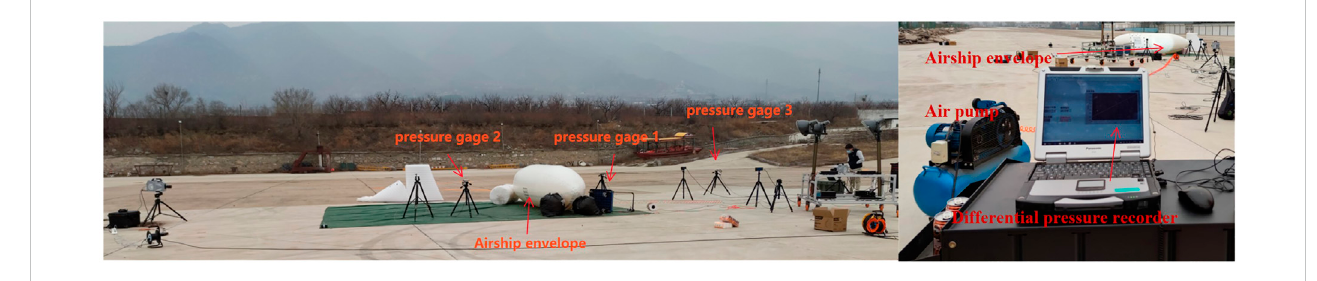
FIGURE 1 Ground explosion test for an airship envelope.